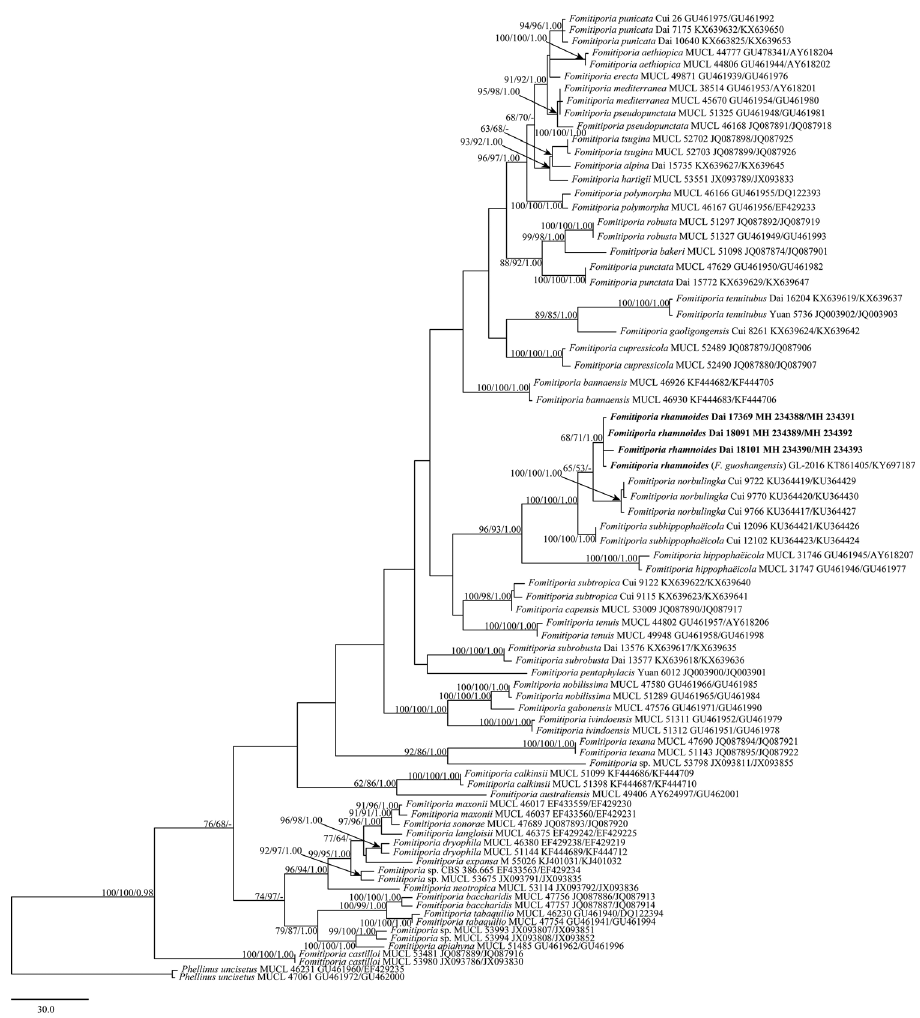
Figure 1. Phylogenetic tree inferred from maximum parsimony (MP) analysis based on the combined data- set of ITS and 28S. Only maximum parsimony (BP), maximum likelihood (BS) and Bayesian posterior prob- abilities (BPP) greater than or equal to 50% (BP), 50% (BS) and 0.95 (BPP) are reported on the